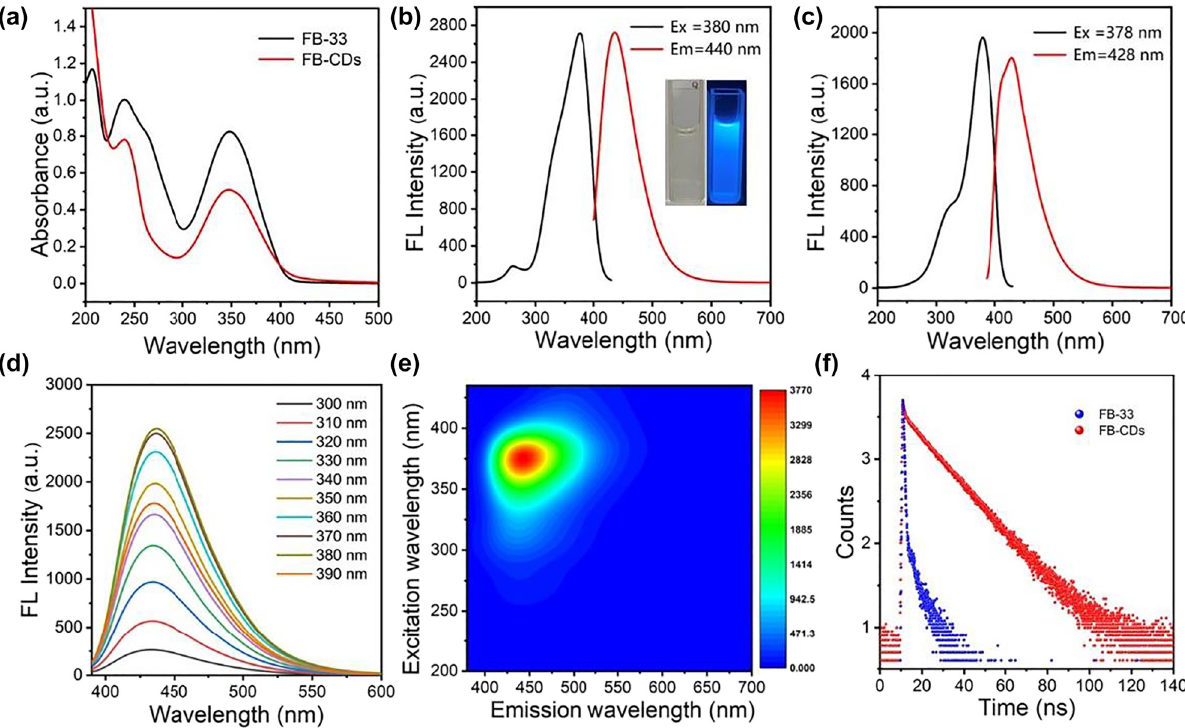
Figure 2: Optical properties of FB-CDs. (a) Ultraviolet–visible (UV–vis) spectrums of the FB-CDs and FB-33 aqueous solution (100 μ g/mL). (b) Fluorescence maximum excitation and emission spectra of FB-CDs (100 μ g/mL). Insets: Photographs of FB-CDs solution under daylight (left) and UV light irradiation (right). (c) Fluorescence maximum excitation and emission spectra of the FB-33 (100 μ g/mL). (d) Fluorescence emission spectra of the FB-CDs collected at various excitation wavelengths. (e) Excitation-emission contour plot of FB-CDs. (f) Time-resolved fluorescence spectra of FB-33 and